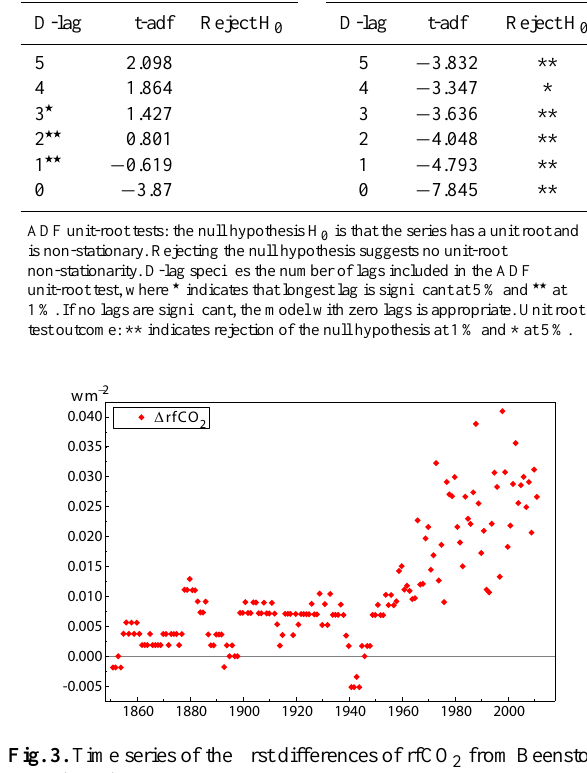
unit-root tests reject non-stationarity of the first difference of N 2 O for the second set of observations (1978–2011). Unit- root non-stationarity cannot be rejected for 1850–1978 for N 2 O: however, given the manifestly artificial appearance of the data such a result should be interpreted with extreme cau- tion. Particularly, the 1 N 2 O series appears to exhibit a step shift in the early 1900s, which also leads to spurious